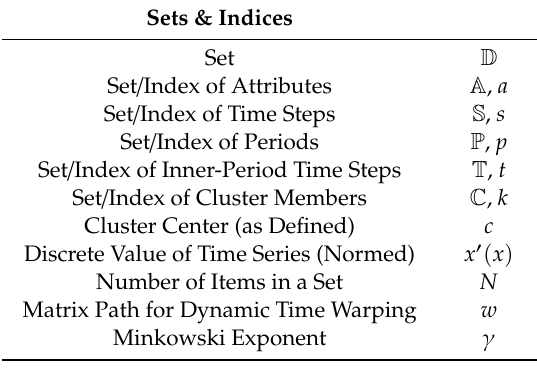
Table 2. Nomenclature for the mathematical examinations in the following section.